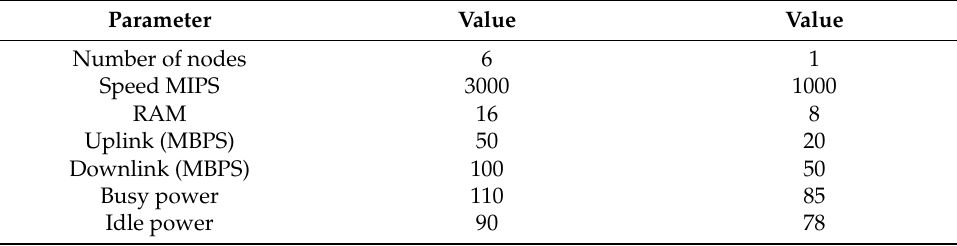
Table 3. iFogSim simulation